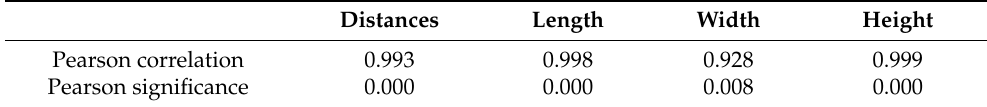
Table 3. Correlation results by the Pearson.